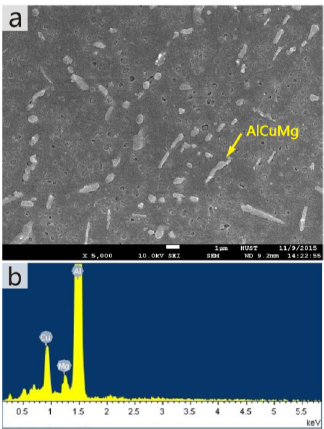
Figure 18. SEM image of an SLM-processed Al-Cu-Mg alloy sample under H4 treatment, ( b ) EDS spectrum corresponding to the AlCuMg phase shown in ( a ) [117]. Copyright 2016. Adapted with the permission from SPIE publishers (Figure 6